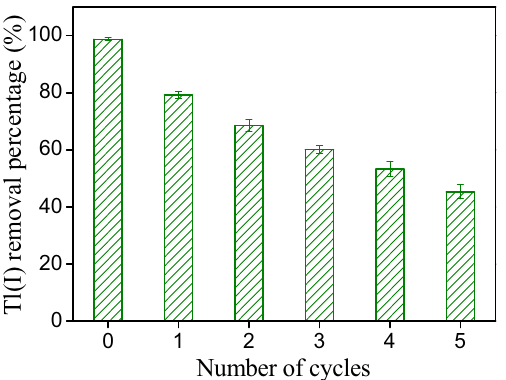
Figure 9. Variation of Tl(I) adsorption by the TiO 2I as a function of regeneration cycle.